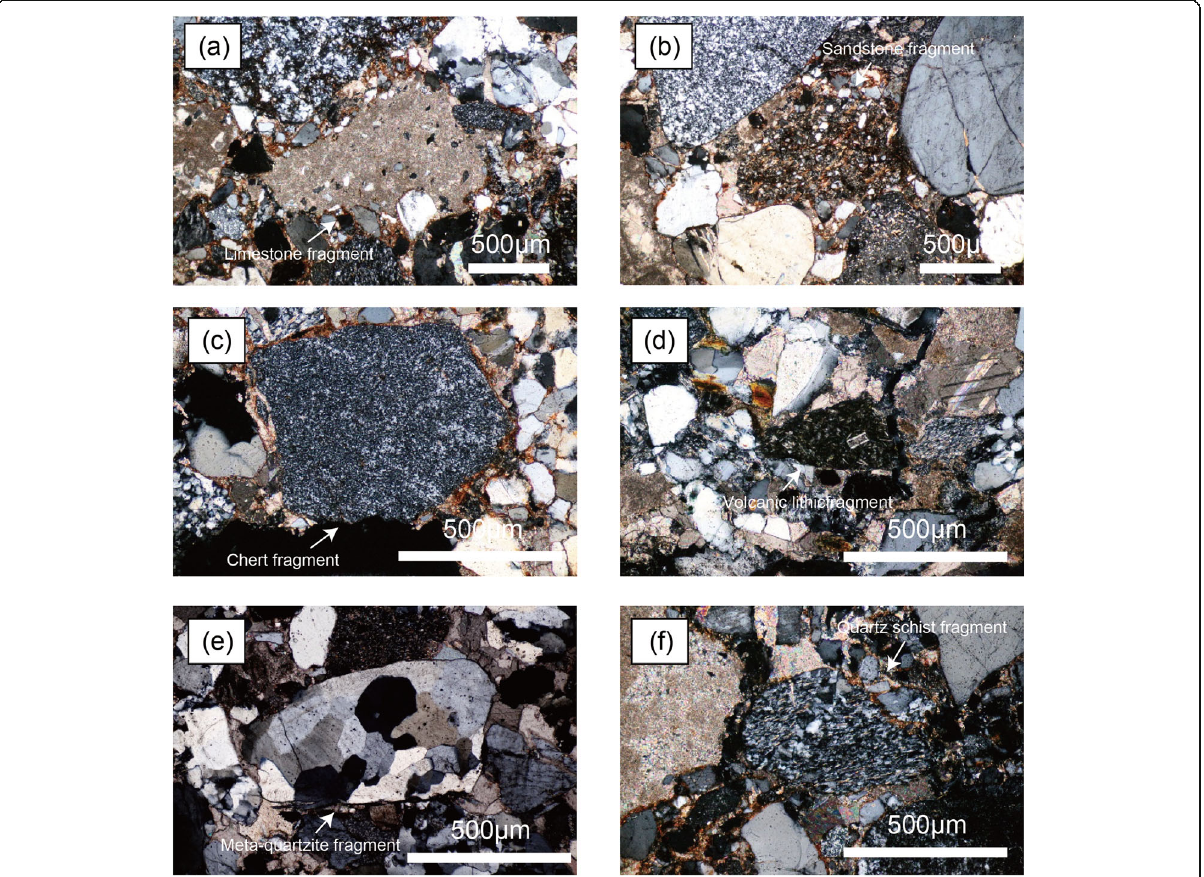
Fig. 5 Optical microscope photographs of various types of lithic fragments in the Aertashi section (all photographs were taken under crossed nicols). a Micritic limestone, b Sandstone, c Chert, d Volcanic rock, e Meta-quartzite, and f Quartz schist